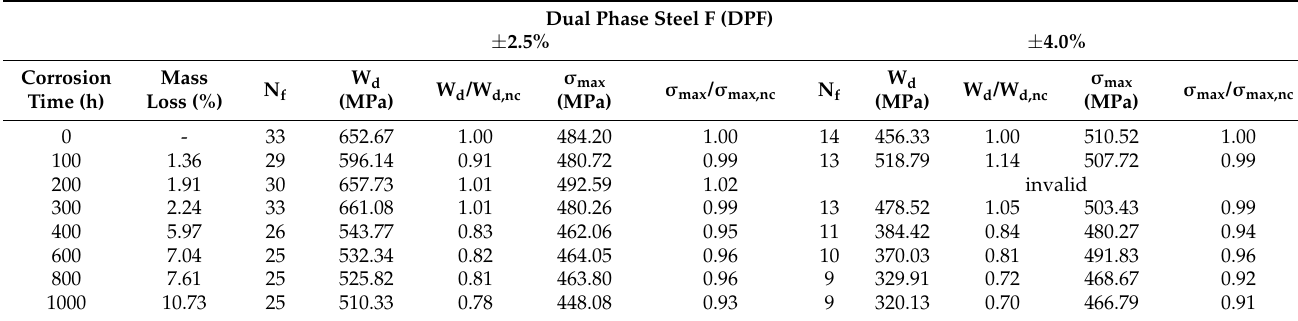
Table 9. Results of LCF tests on Dual Phase steel F (DPF) (mean values). Dual Phase Steel F (DPF) ± 2.5%